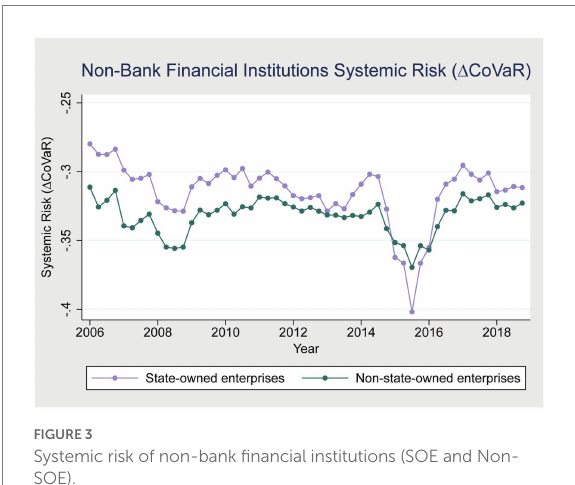
FIGURE 3 Systemic risk of non-bank financial institutions (SOE and Non-